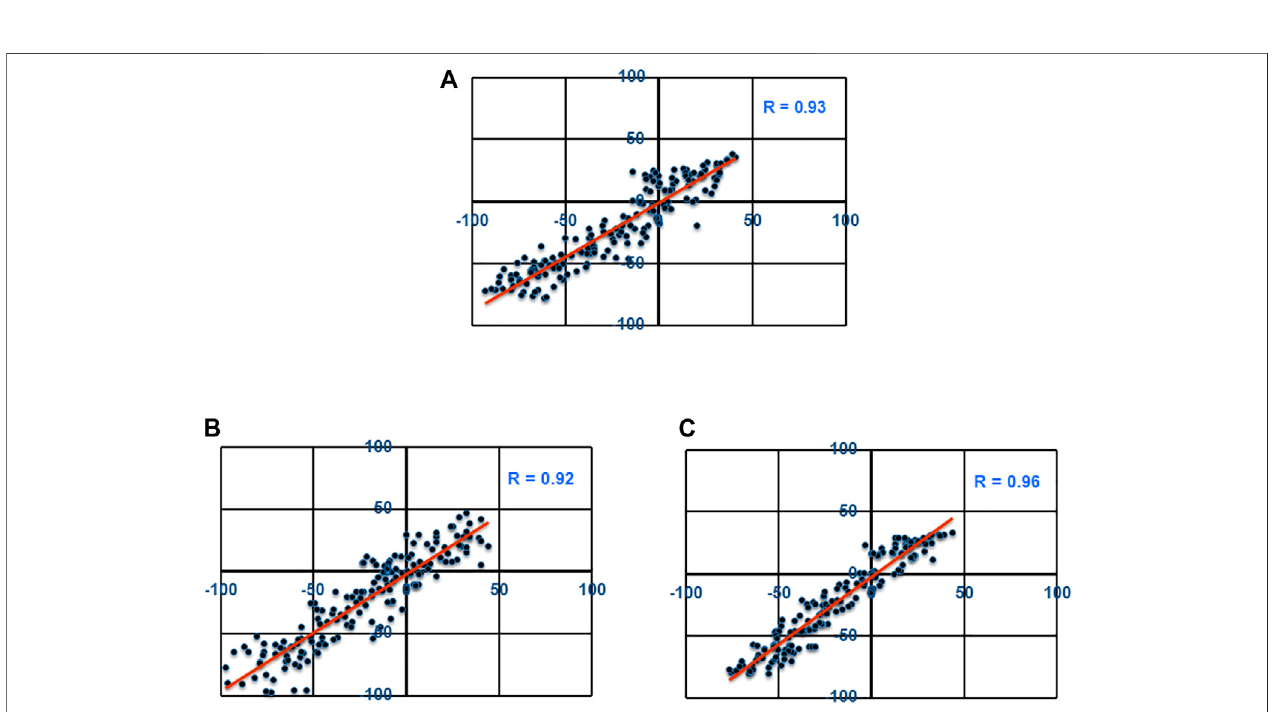
FIGURE 11 | Correlation coef fi cients (R) between Δ TWS data from averaging of the monthly GRACE spherical harmonic solutions and averaging of the mascon solutions (A) , monthly CSR spherical harmonic solution and monthly JPL spherical harmonic solution (B) , CSR and JPL mascon solutions (C) over the Saudi Arabia throughout the investigated